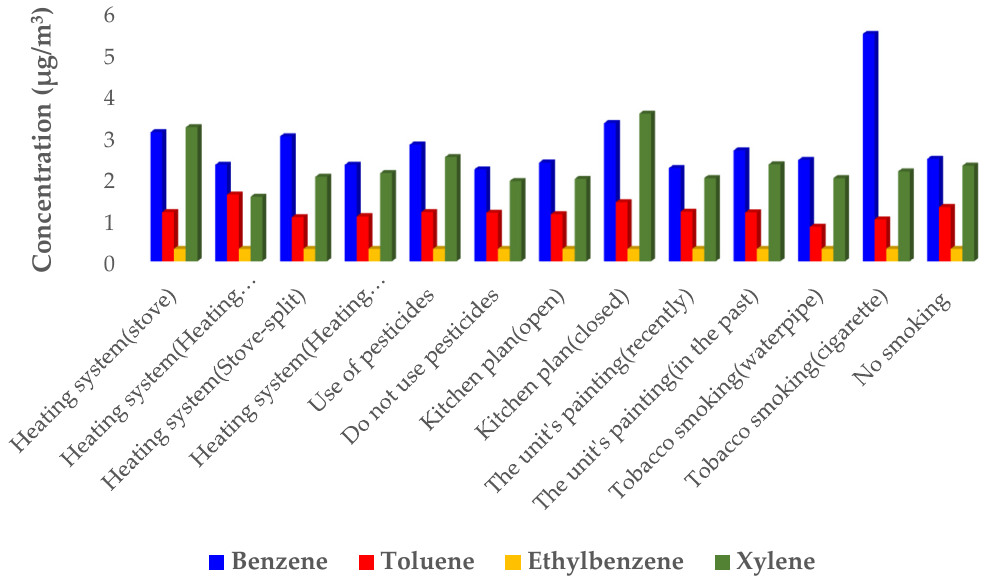
Figure 3. The relationship between the concentration of BTEX pollutant ( μ g/m 3 ) and construction parameters in the upper residential units of the residential-commercial complexes.